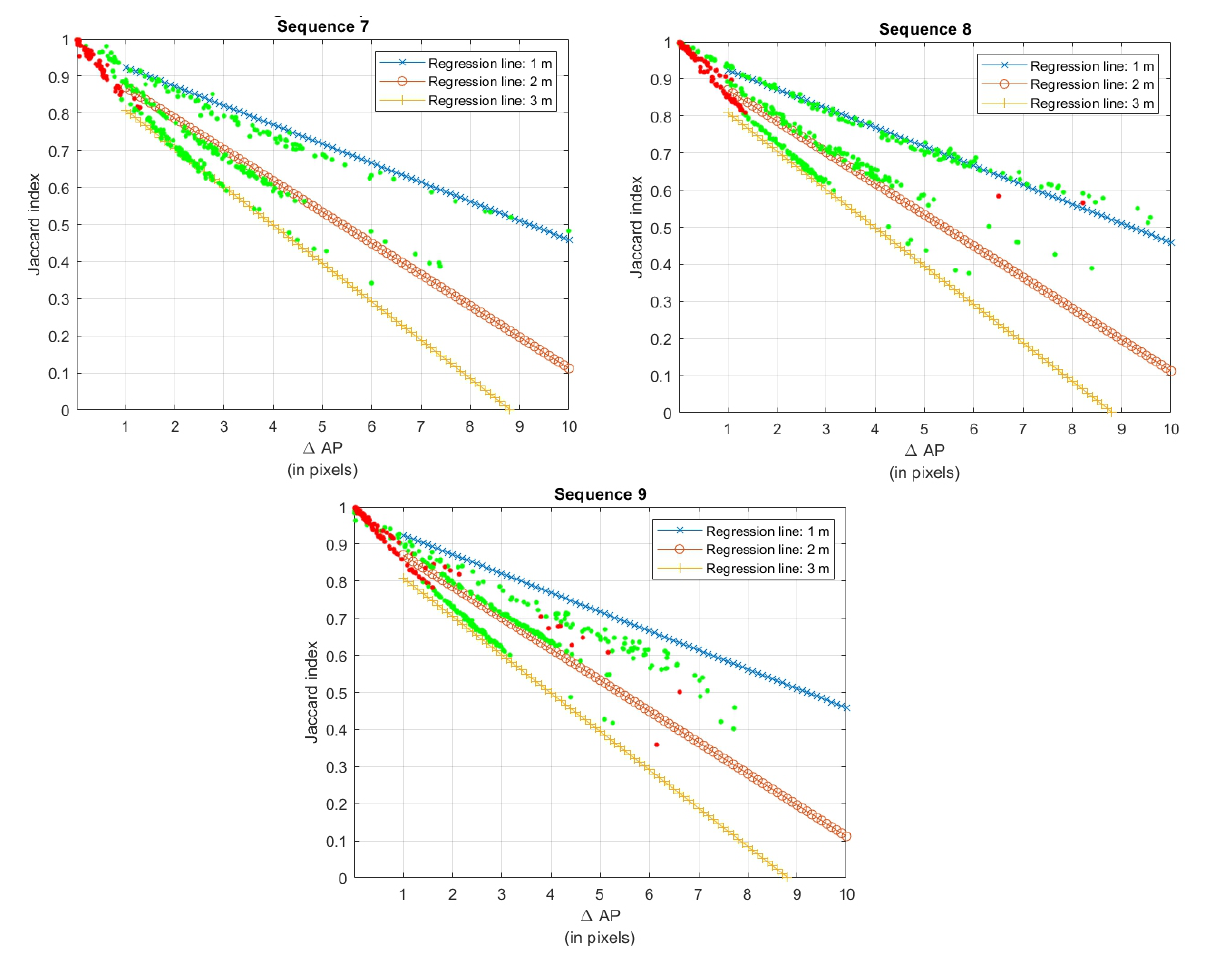
Figure 12. Results—test set—sequences 7–9 from Figure